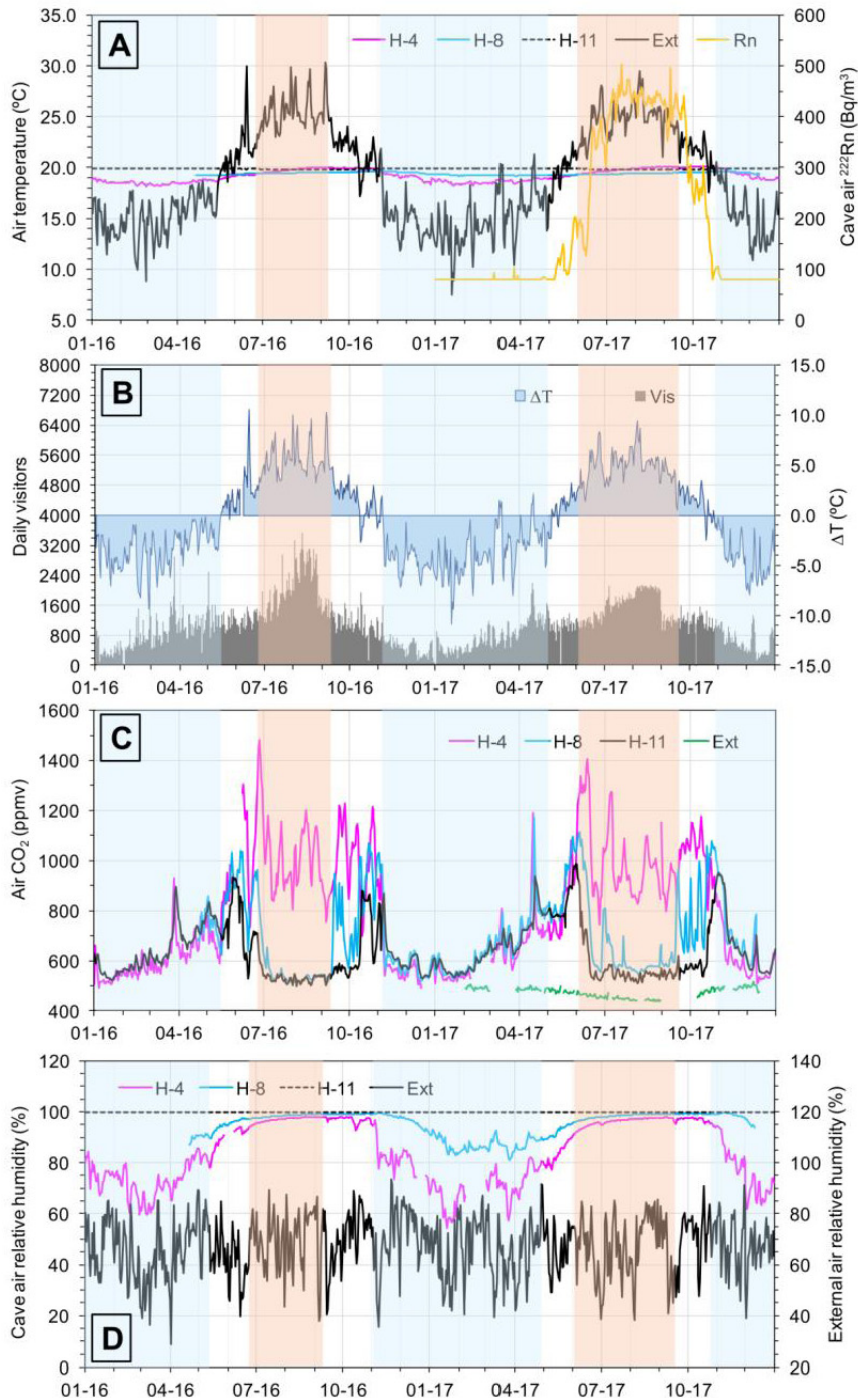
Figure 2. Daily evolution from 01/01/16 to 31/12/17 of ( A ) external and cave air temperatures in Nerja Cave versus air 222 Rn concentration in H-4 (average for the period 2008–2013); ( B ) daily visitors versus air temperature differences ( ∆ T = T ext − T int ); T ext : external air temperature; T int : internal air temperature (H-4); ( C ) air CO 2 content. Data of external air CO 2 correspond to year 2018 and ( D ) external and cave air relative humidity. Blue bars: winter ventilation period, UAF-mode. Yellow orange bars: summer ventilation period, DAF-mode. 3.2. Aerobiology